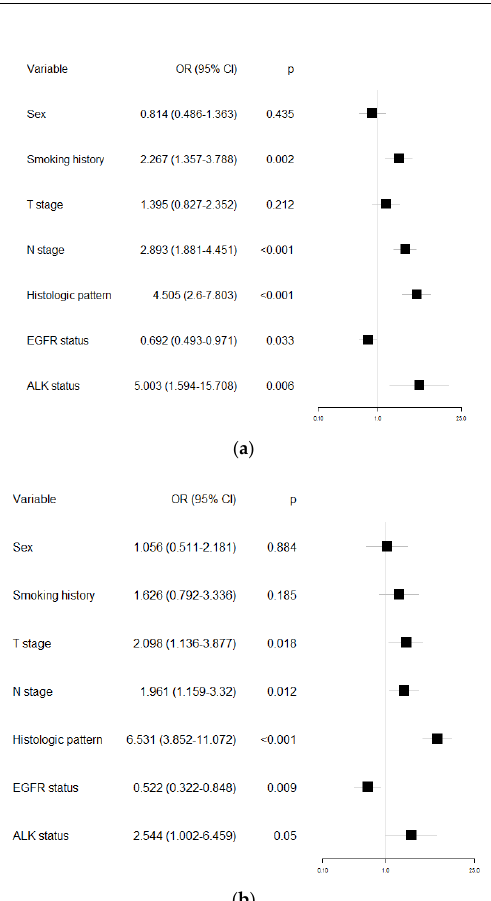
Figure 2. Forest plots reflecting the results of multivariate logistic regression analysis of clinicopathological features for PD-L1 expression in lung adenocarcinoma: ( a ) 1% cuto ff value for PD-L1 positivity; ( b ) 50% cuto ff value for PD-L1